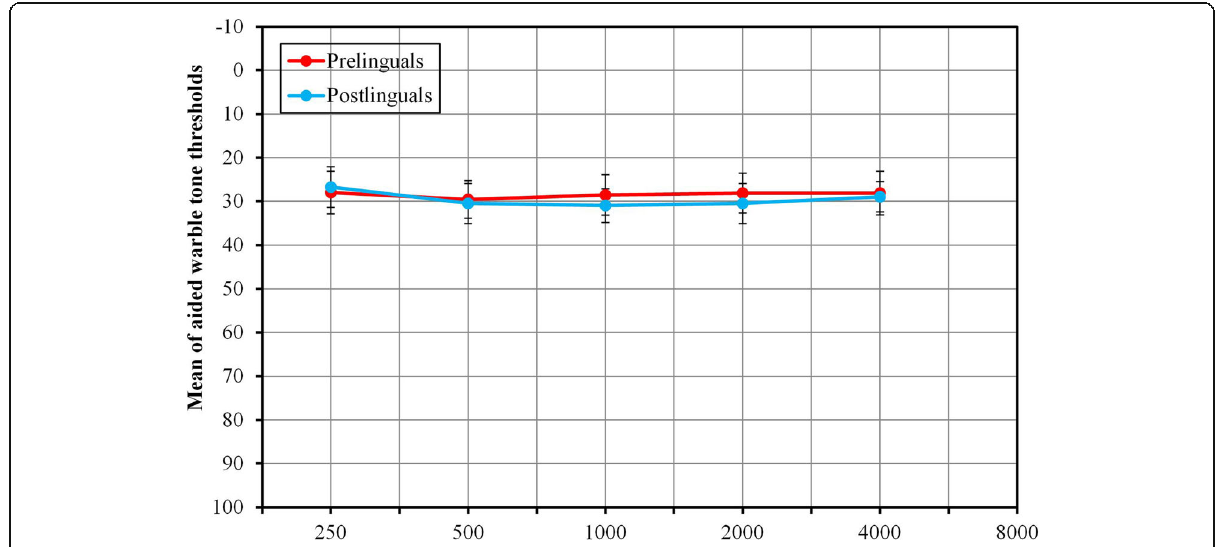
Fig. 1 Mean and standard deviation of aided free field thresholds of prelingual and postlingual CI patients